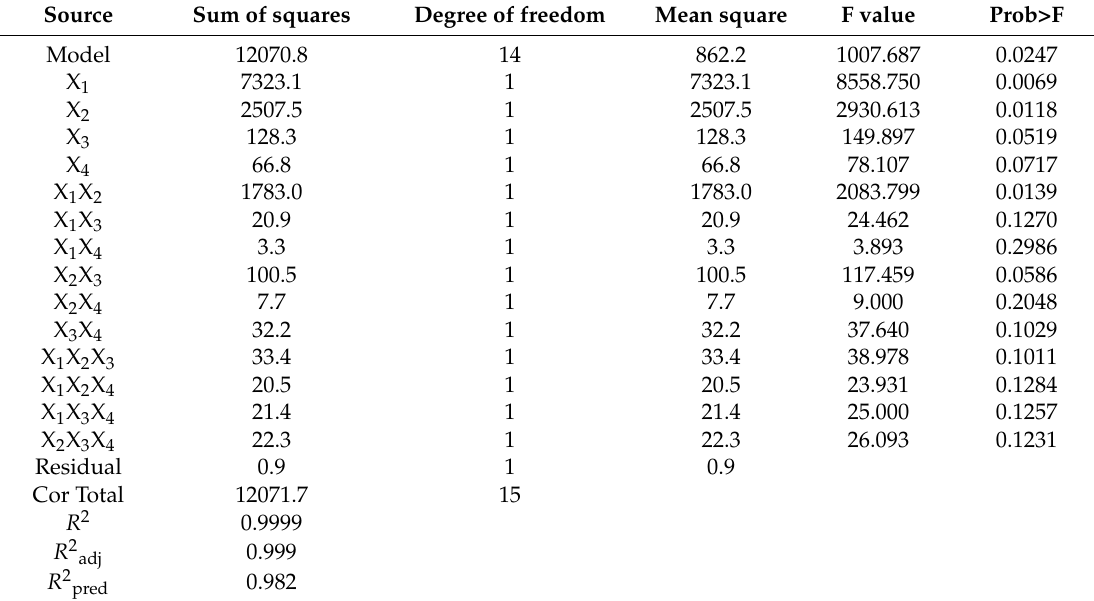
Table 2. Full statistical result of ANOVA for response variable